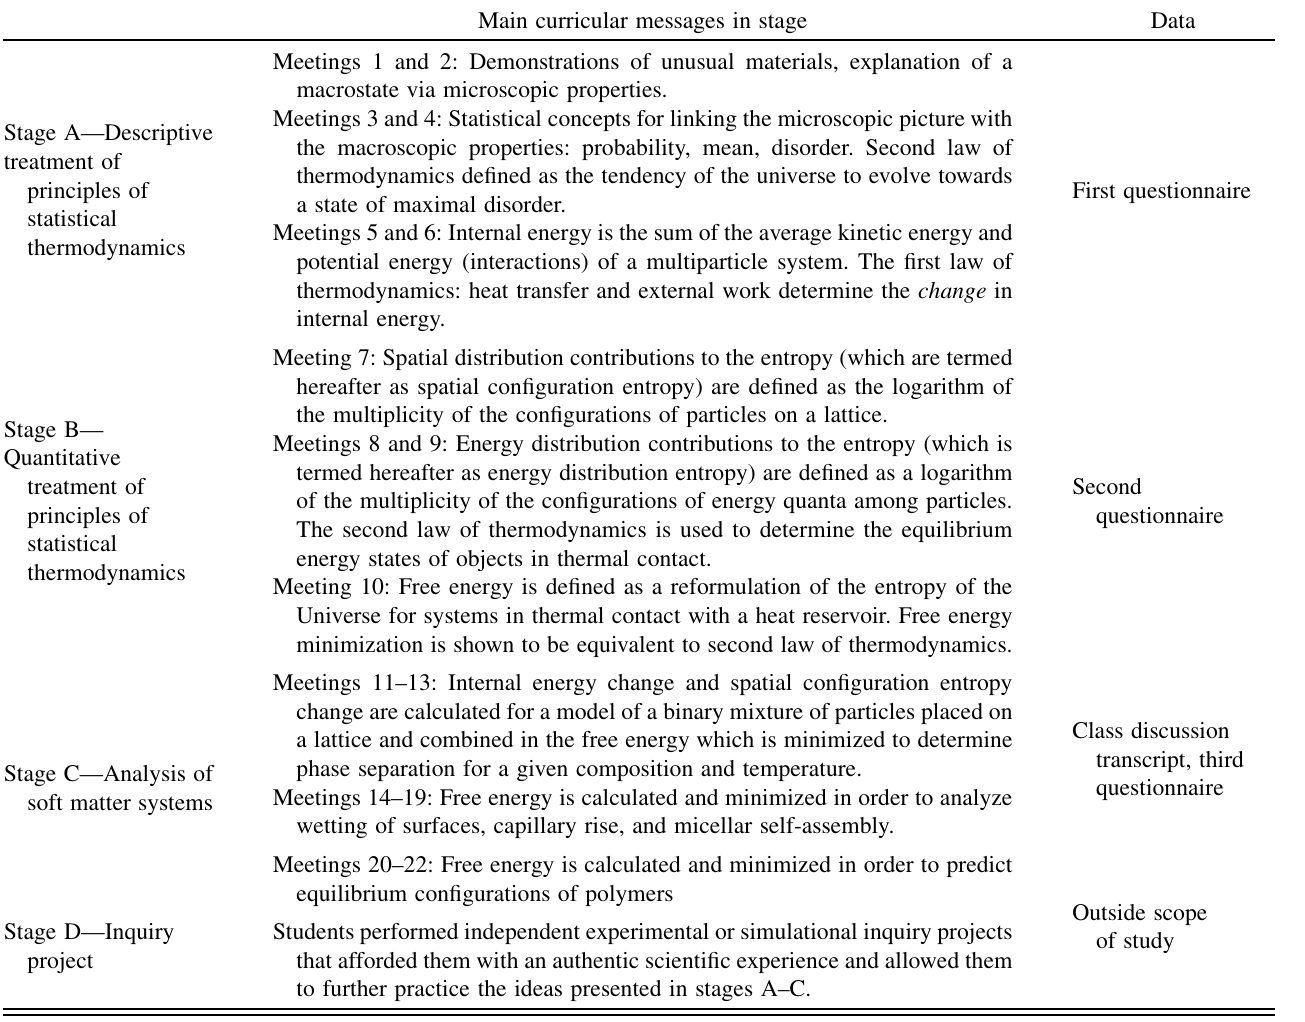
TABLE II. Teaching sequence outline and corresponding data collection